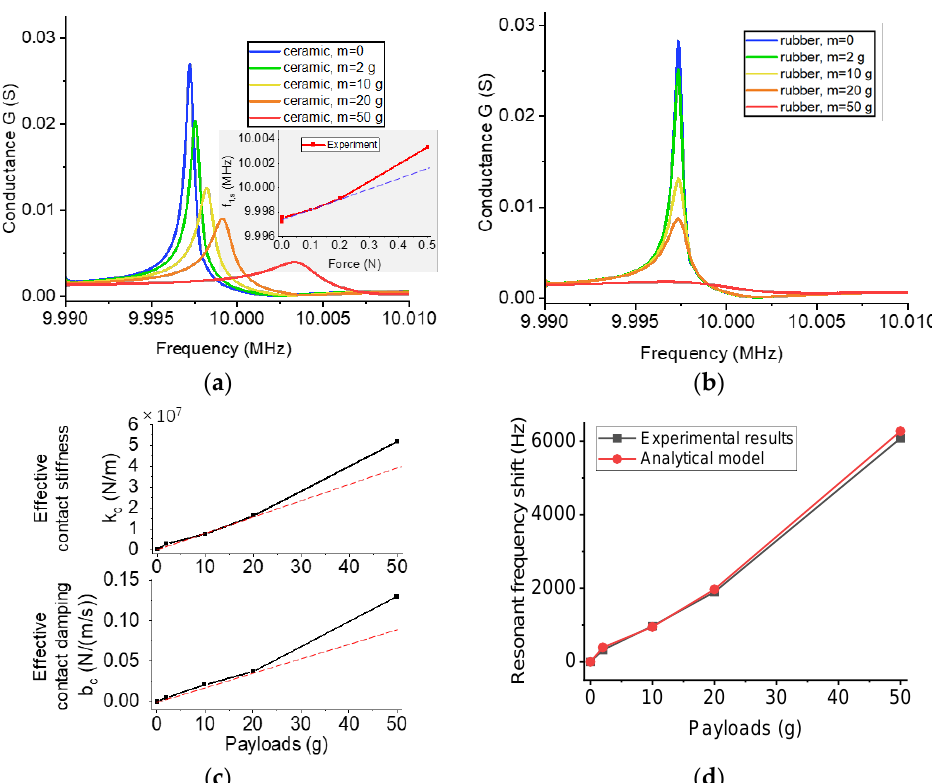
Figure 3. Experimental characterization of quartz wafers in contact with different contact units. ( a , b ) Conductance vs. resonance for a contact unit made of ceramic and rubber, respectively. ( c ) The effective contact spring and damping coefficient as a function of payloads. ( d ) Payloads vs. resonance shift in experimental and analytical results.